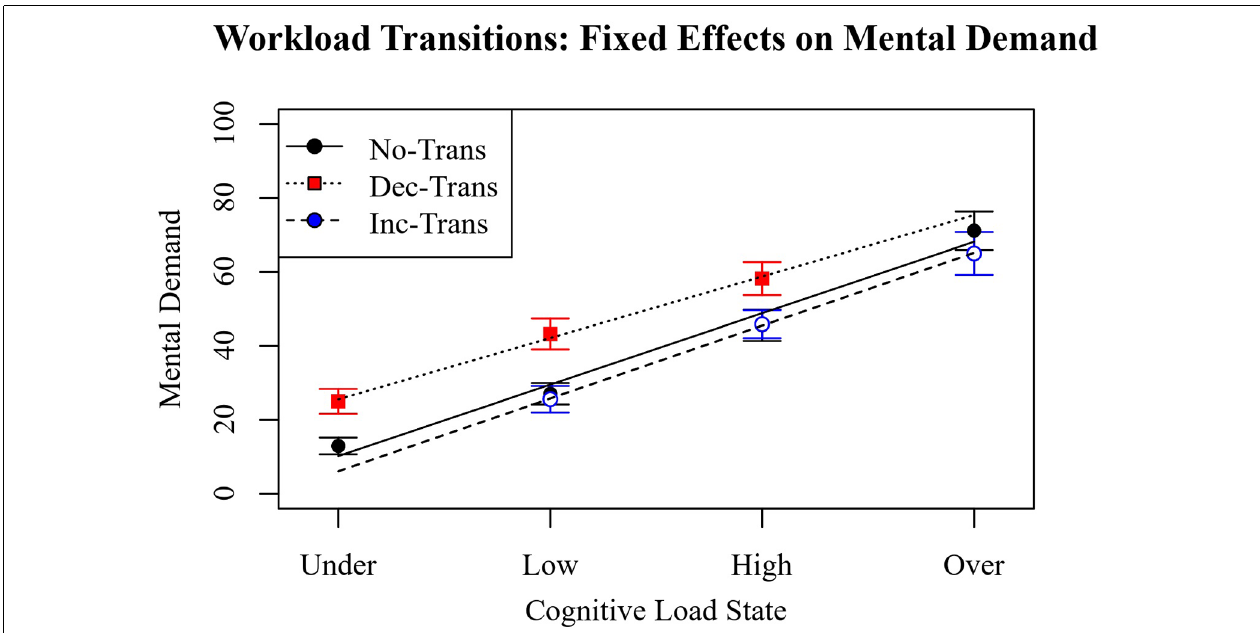
FIGURE 8 | NASA Task Load Index (NASA TLX) mental demand scores comparing the effect of no-transition, transitions of increasing cognitive load, and transitions of decreasing cognitive load across different cognitive load states.